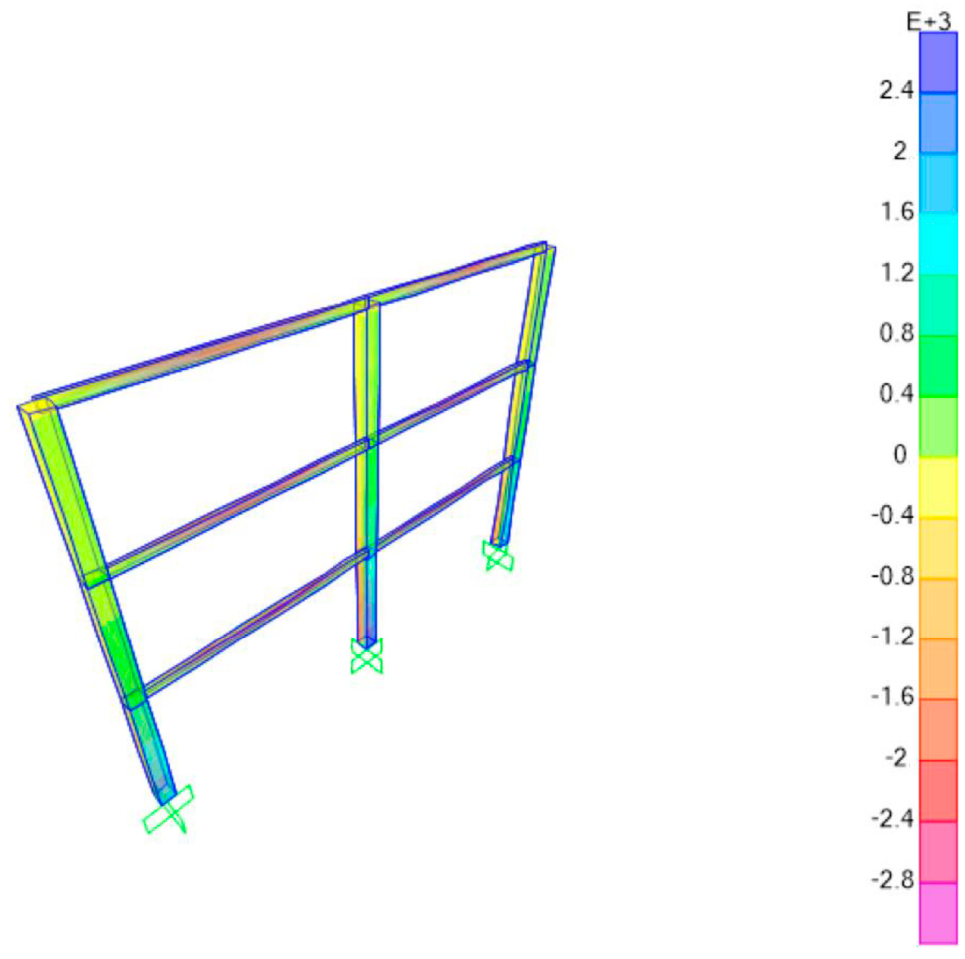
Figure A14. Stress contour of a two-section system, where the max stress of 2.81 MPa occurs at the base of the interior post.